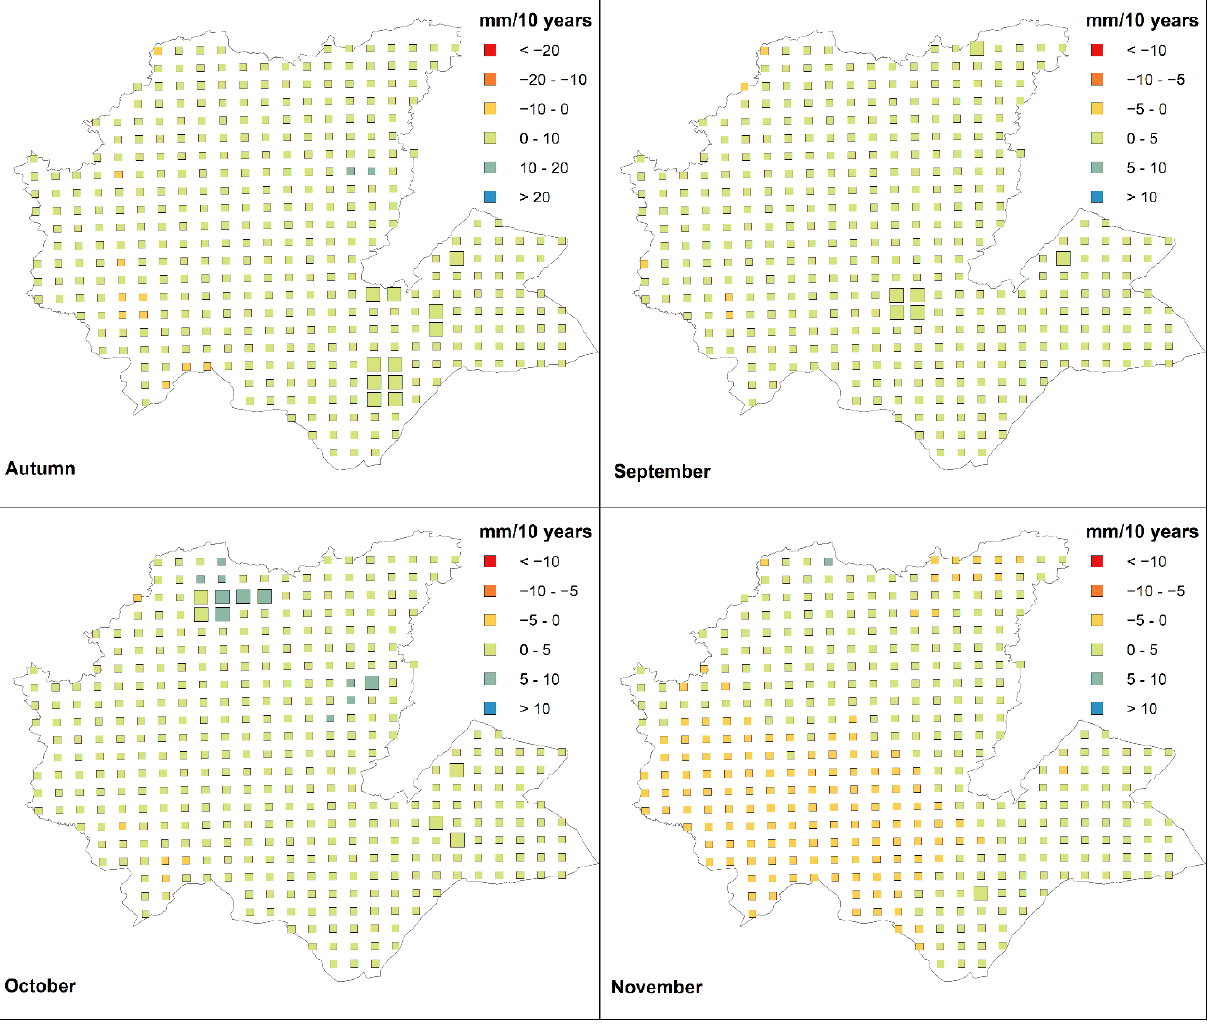
Figure 5. Theil – Sen Slope and MK test for autumn season and its constituent months. Squares ’ dimensions indicate the significance level of the trend: large squares: p < 0.05, small squares otherwise.